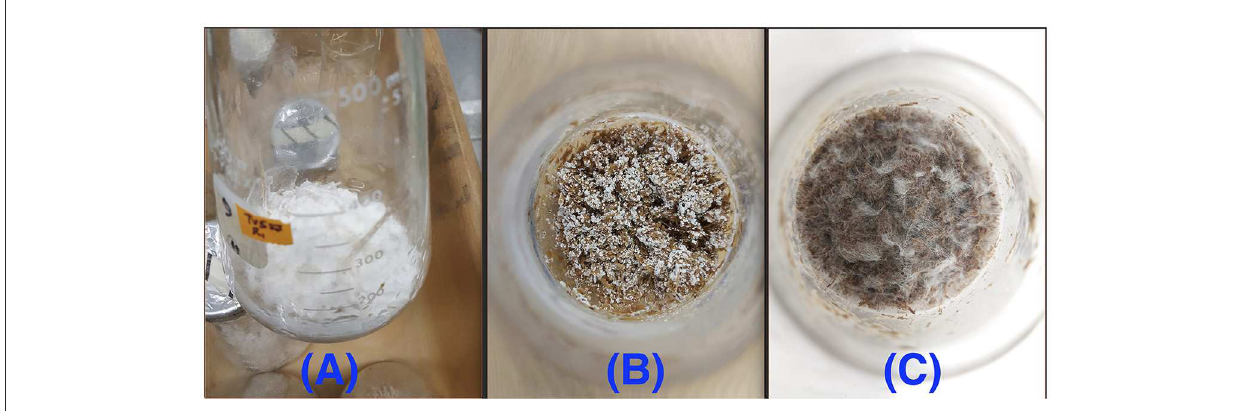
FIGURE2 Fungal growth on the lignocellulosic substrates after 14 d: (A) : CS-TV52J, (B) : SG-TVm4D, (C) : CS-PC. PC, P. chrysosporium ; TV52J, T. versicolor 52J; TVm4D, T. versicolor m4D; CS, camelina straw; SG, switchgrass.